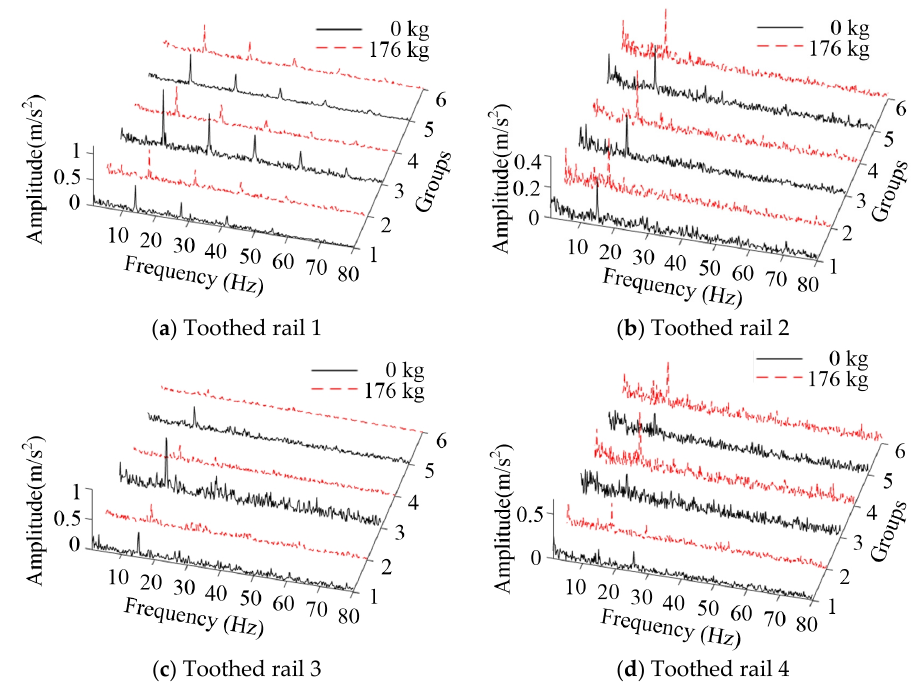
Figure 15. The Hilbert envelope demodulation frequency analysis of vibration acceleration.